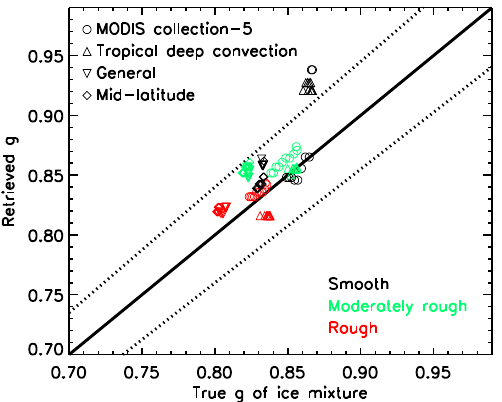
Fig. 8. As for Fig. 6, but for simulated data assuming various ice crystal habit mixtures. Circles denote the MODIS collection-5 mix- ture of Baum et al. (2005a,b) and the other symbols denote mixtures of Baum et al.